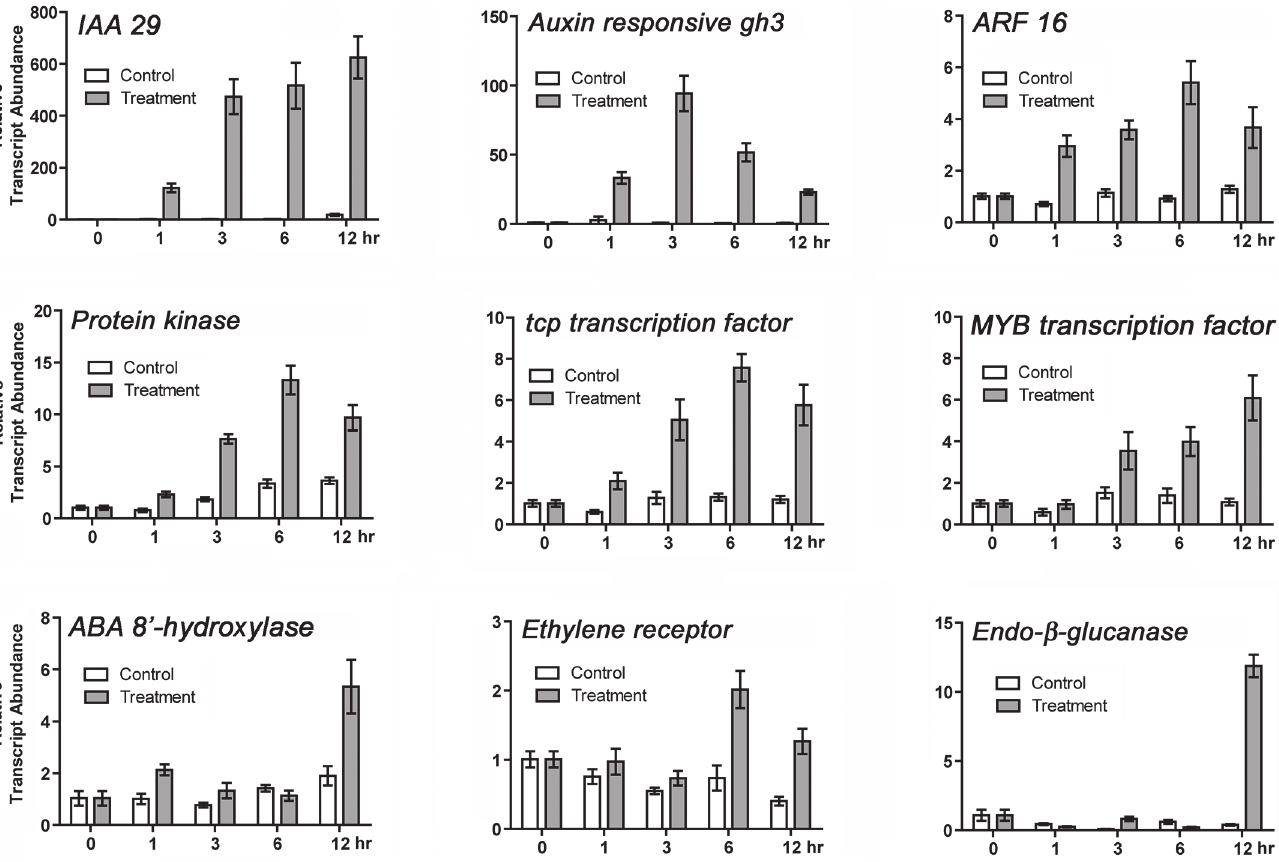
Fig 4. Validation of array data by RT-qPCR analysis. Genes differentially expressed due to exogenous auxin and GA treatment of unfertilized cotton ovules (-1 DPA) for 0, 1, 3, 6, and 12 h included: IAA 29 (Gorai.001G043900)), auxin responsive gh3 (Gorai.005G234200), ARF 16 (Gorai.011G238900), protein kinase (Gorai.008G294700), tcp transcription factor (Gorai.012G166500), MYB transcription factor (Gorai.013G196800), ABA 8'-hydroylase (Gorai.004G177200), ethylene receptor (Gorai.002G038300), endo- β -glucanase (Gorai.007G126900). All RT-qPCR analyses were performed with three biological replications for each time point with five technical replications. The error bars represent the SD.